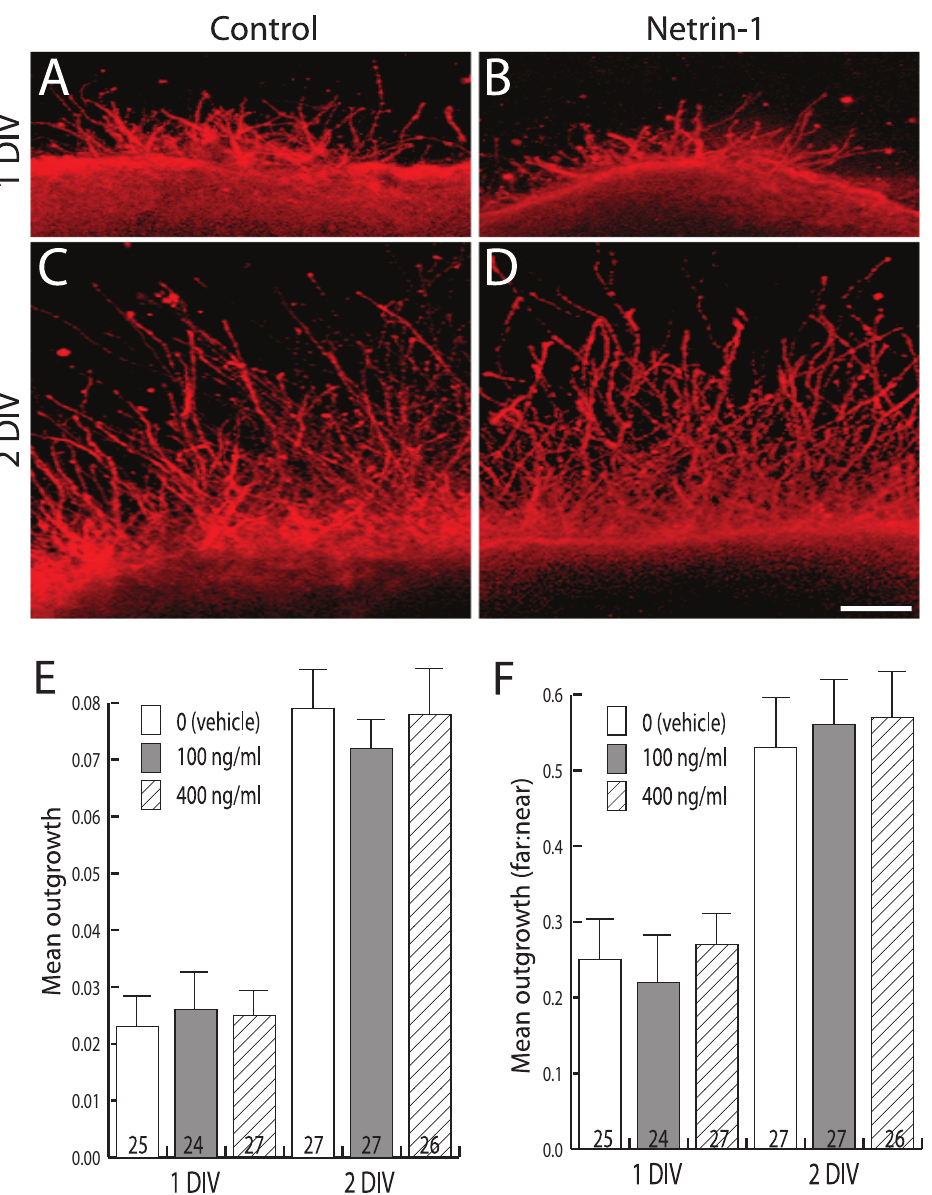
Figure 3. Netrin-1 does not affect the outgrowth of TuJ1 + neurites in POA explants. (A-D) Representative images of explants cultured as indicated for 1 or 2 DIV in the presence of 100 ng/ml Netrin-1 (Netrin-1) or control. Scale bar, 70 m m. (E) Bar graph showing the mean outgrowth of TuJ1 + neurites (y-axis) across indicated culture conditions (x-axis) at 1 or 2 DIV. Numbers at the base of each bar indicate the number of explants used, and are from fetal brains derived from 5 independent pregnancies. Error bars indicate SEM. (F) Bar graph showing the mean far: near ratio (y- axis) for neurite lengths across culture conditions (x-axis) as indicated by inset legend. Decorations as in E. Error bars indicate SEM.